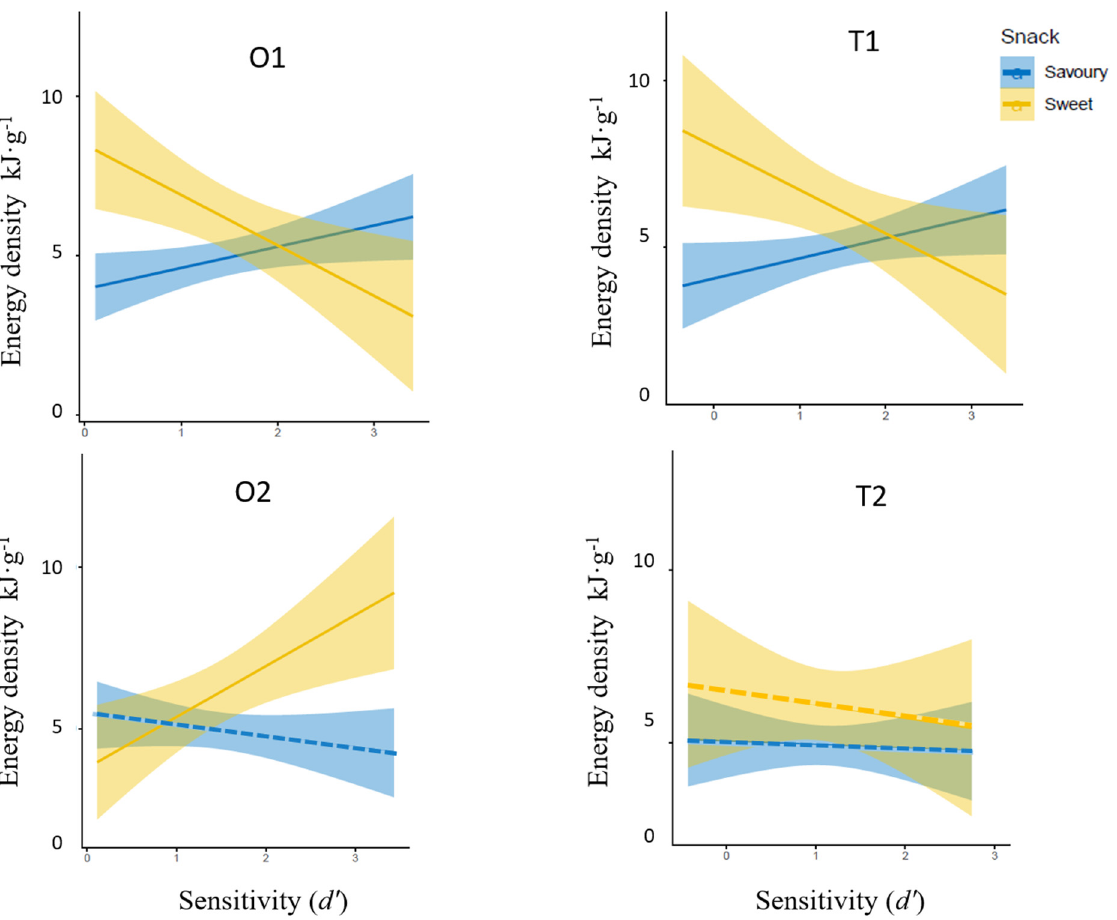
Figure 2. Correlations between sensitivity and energy density of sweet and savoury snack consumption for two-olfactory (O1—vanillin, O2—methional) and two-gustatory stimuli (T1—sucrose, T2—NaCl). Significant correlations were denoted by solid lines and non-significant correlations by dashed lines.